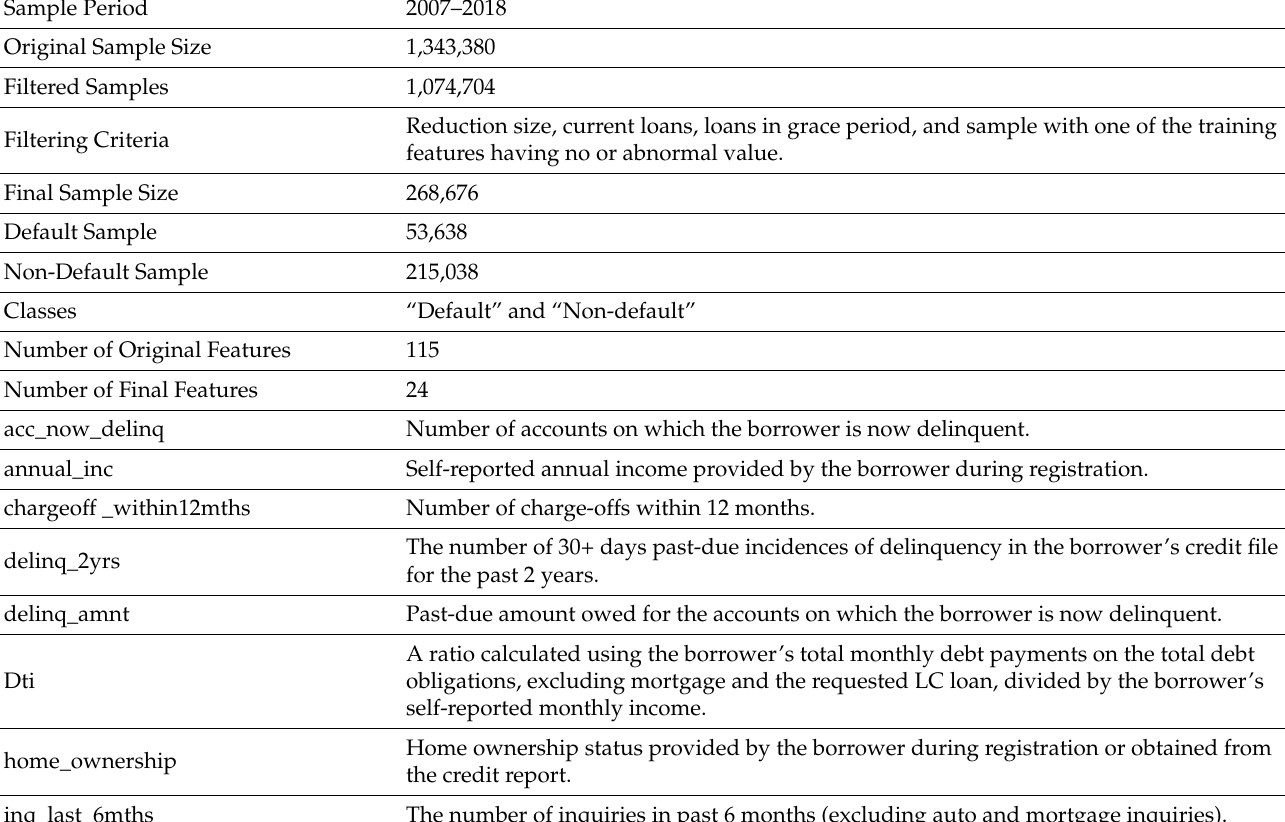
Table 2. Summary of the Lending Club dataset used in both the classification and prediction